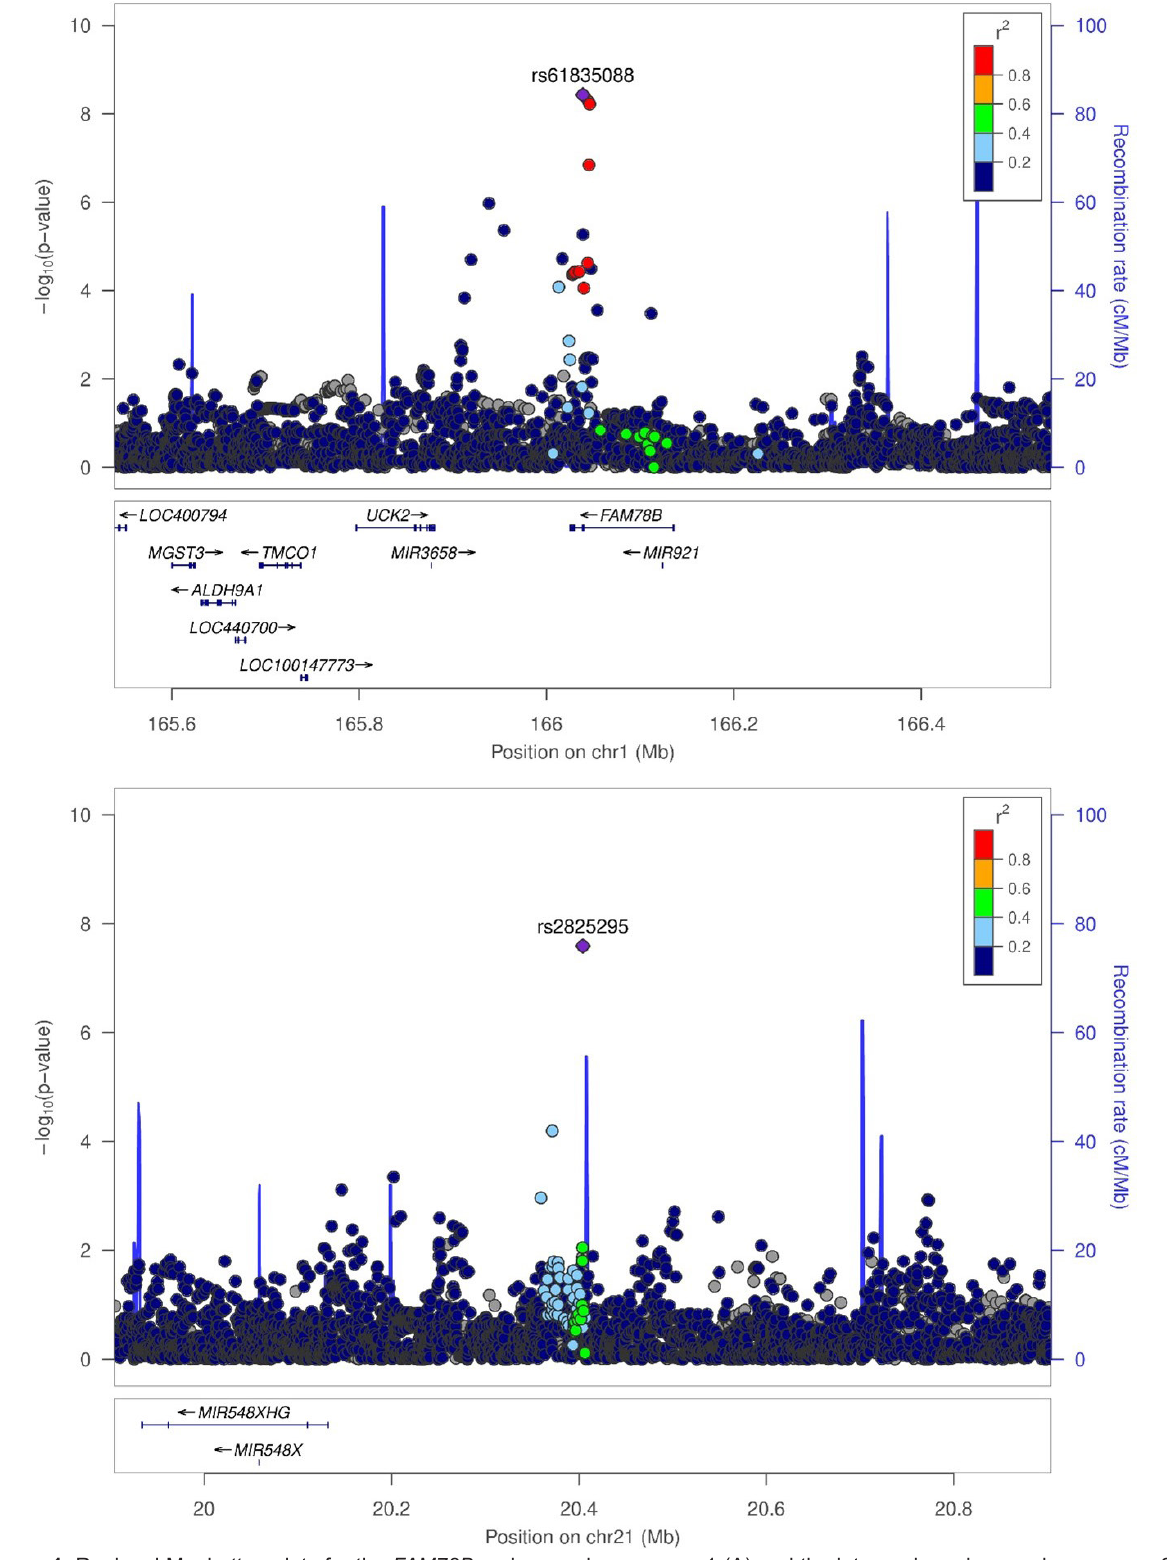
(B) for time to CD in AAs in the Yale-Penn cohort. SNPs are color coded according to the correlation coefficient ( r 2 ) in the 1,000 Genomes African reference panel with the top-ranked SNP. Light blue line indicates the observed recombination rate (right-side